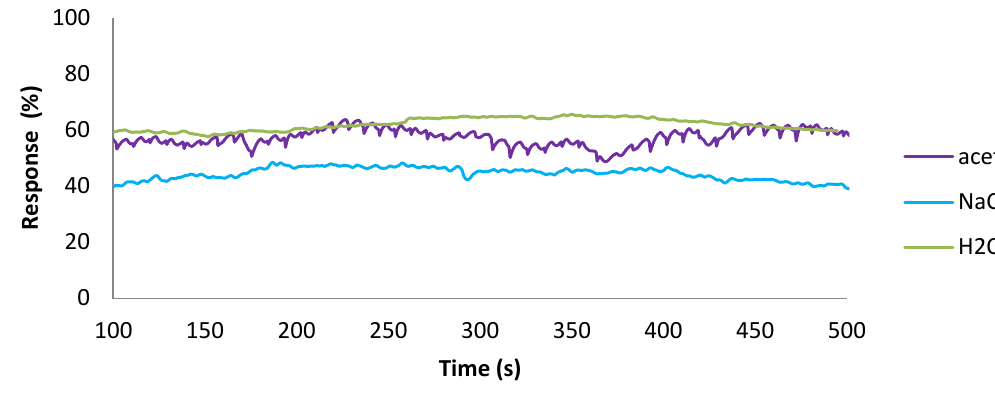
Figure 5. Response on flow rate with Demiwater (H